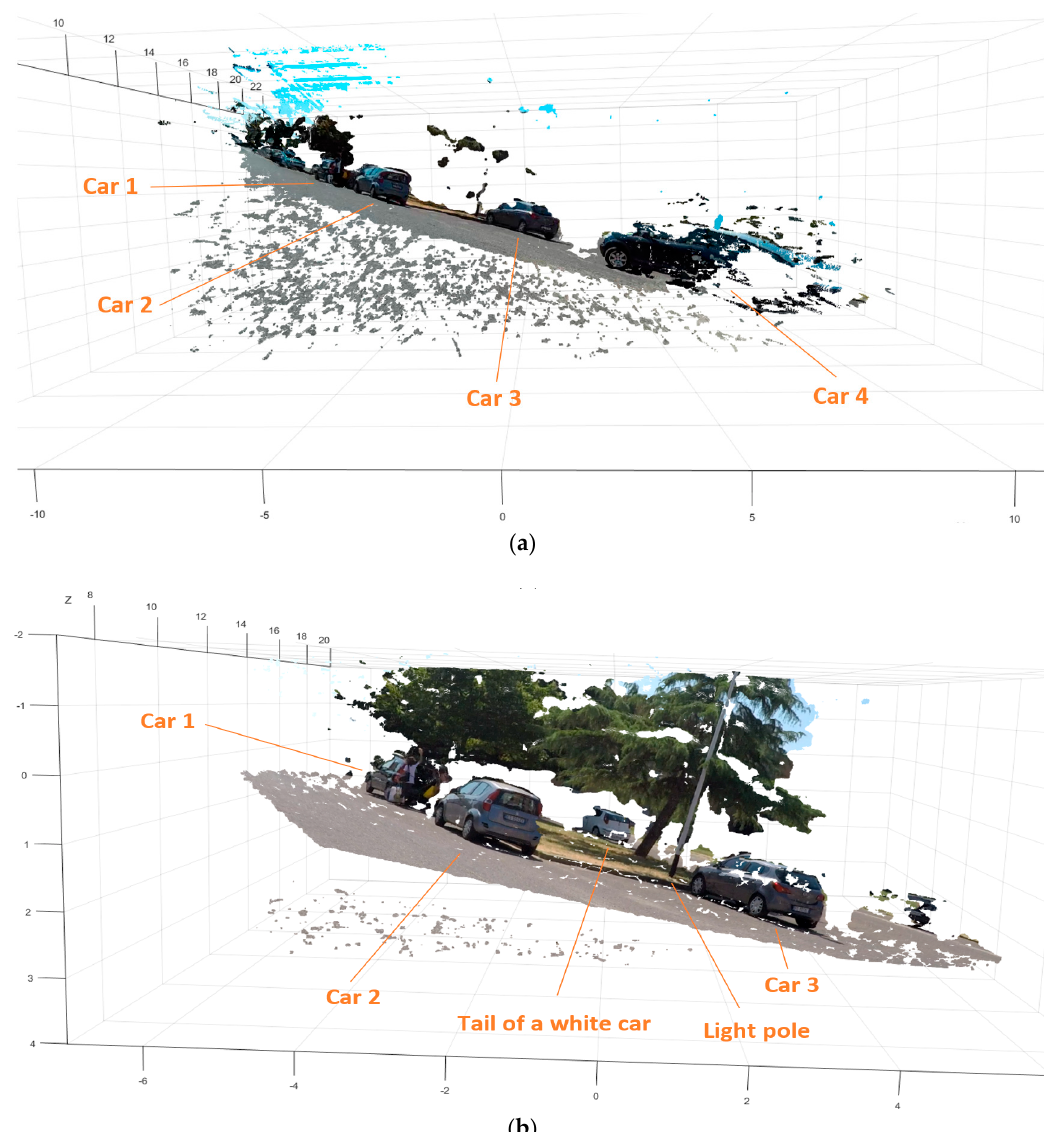
Figure 9. 3D point clouds corresponding to the turning maneuver scene calculated from the information provided by the two stereo camera sensors. ( a ) Reconstruction for the short-range stereo camera (wide common Field of View); ( b ) Reconstruction for the long-range stereo camera (narrow common Field of View).